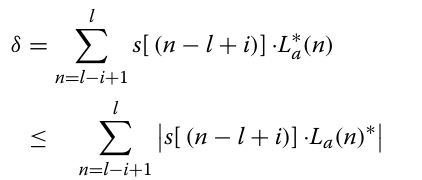
Table 1 Residue vs. sync precision Chirp f slope Sync precision T step Residue ratio w ≤ 20 MHz/us 5 ns 50% ≤ 40 MHz/us 2.5 ns 43%